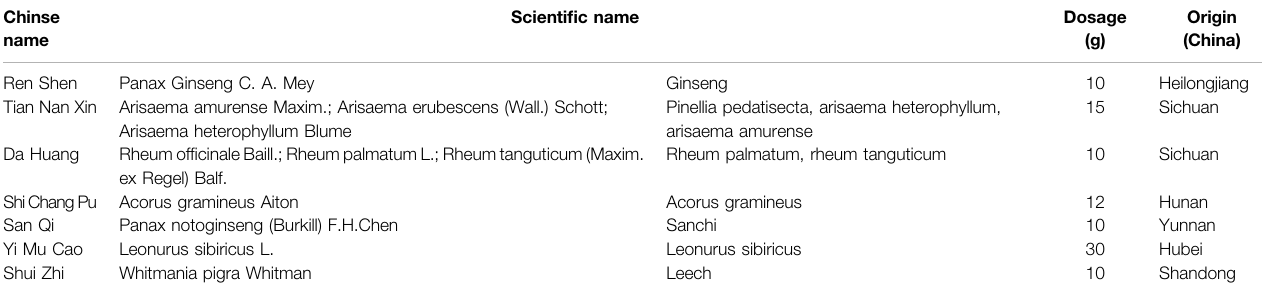
TABLE 1 | Herbs in FYXN.